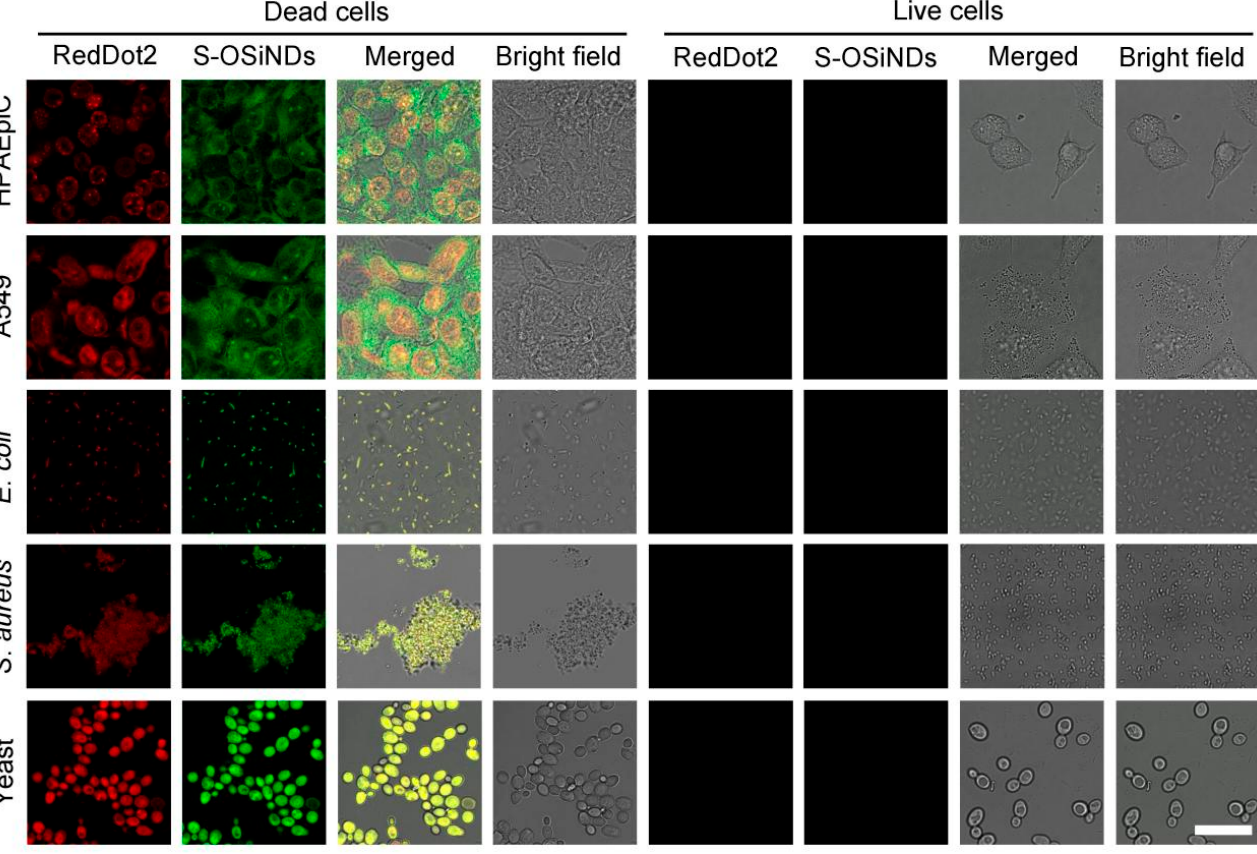
Figure 11. Confocal images of live/dead cells (HPAEpiC, A549, E . coli , S . aureus , and S . cerevisiae yeast) stained with S ‐ OSiNDs (5 μ g/mL) and RedDot2 (diluted with PBS (for mammalian cells)/physiological saline (for bacteria and fungi) using a 1:200 ratio) for 10 min. Note that the fluorescence emission color of S ‐ OSiNDs was set as green.